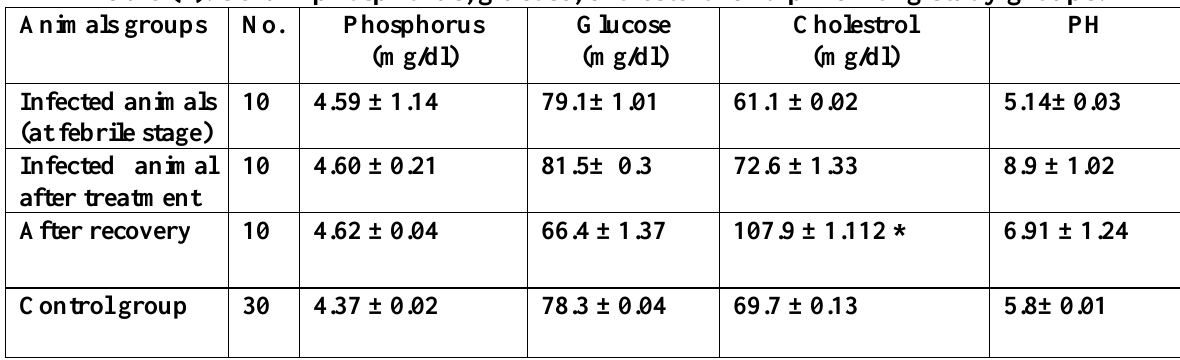
Table (1): Serum phosphorus, glucose, cholesterol and pH among study